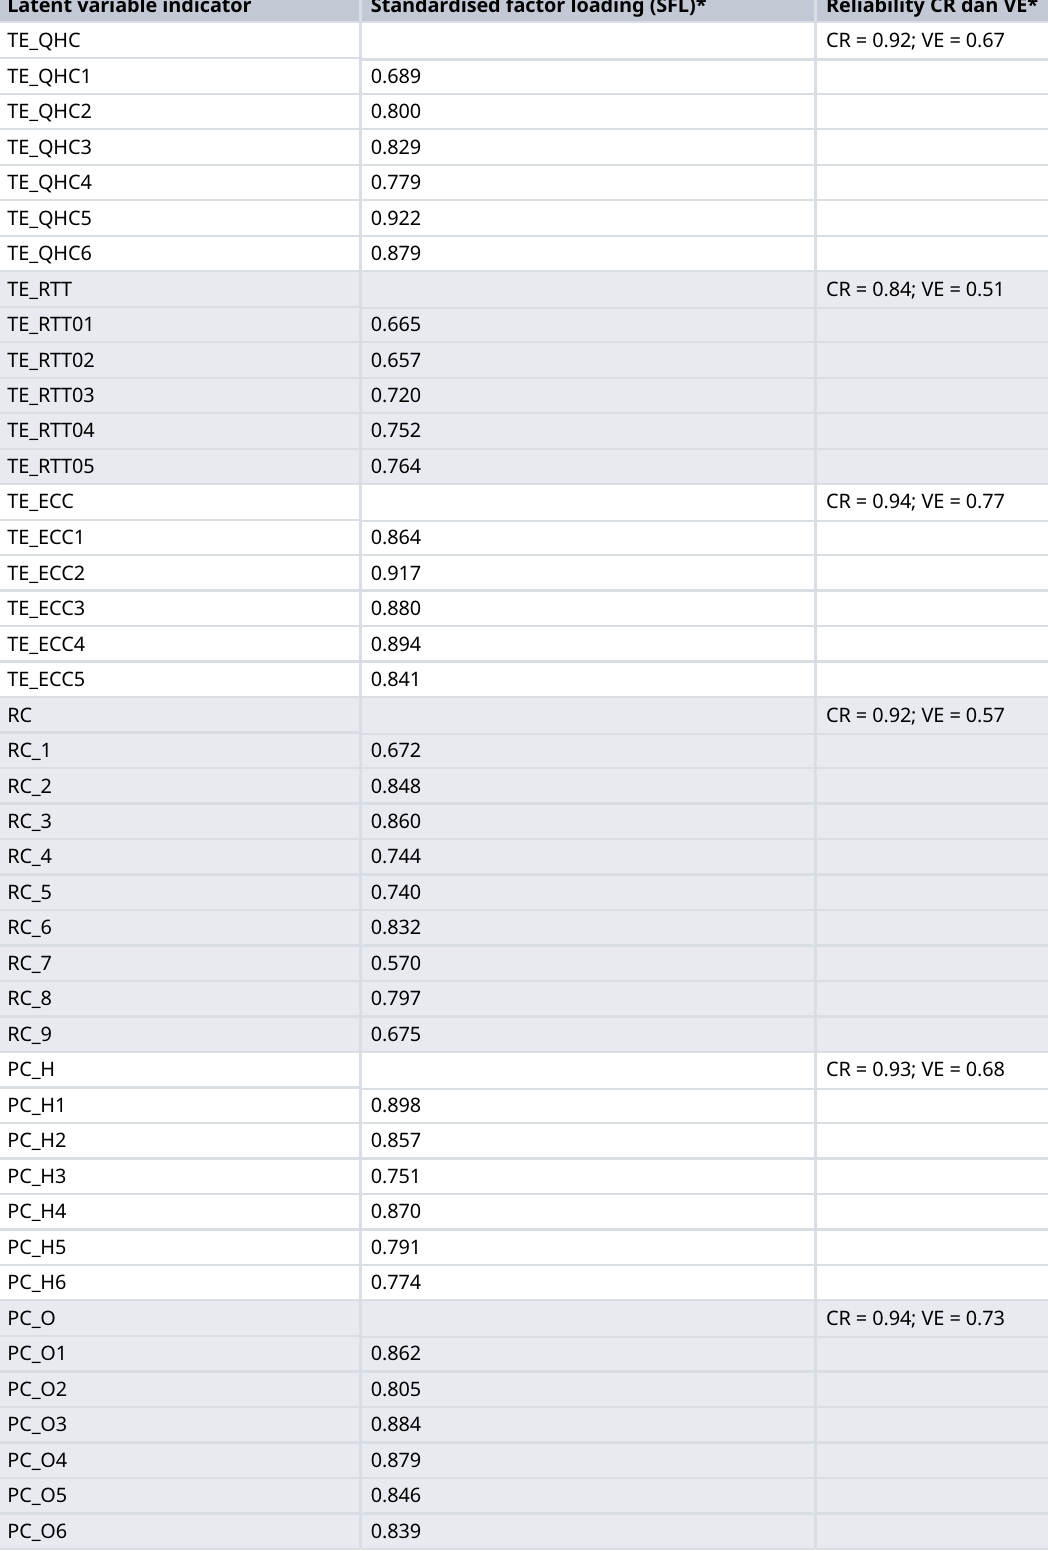
Table 1. Standardised factor loading, composite reliability, and average variance